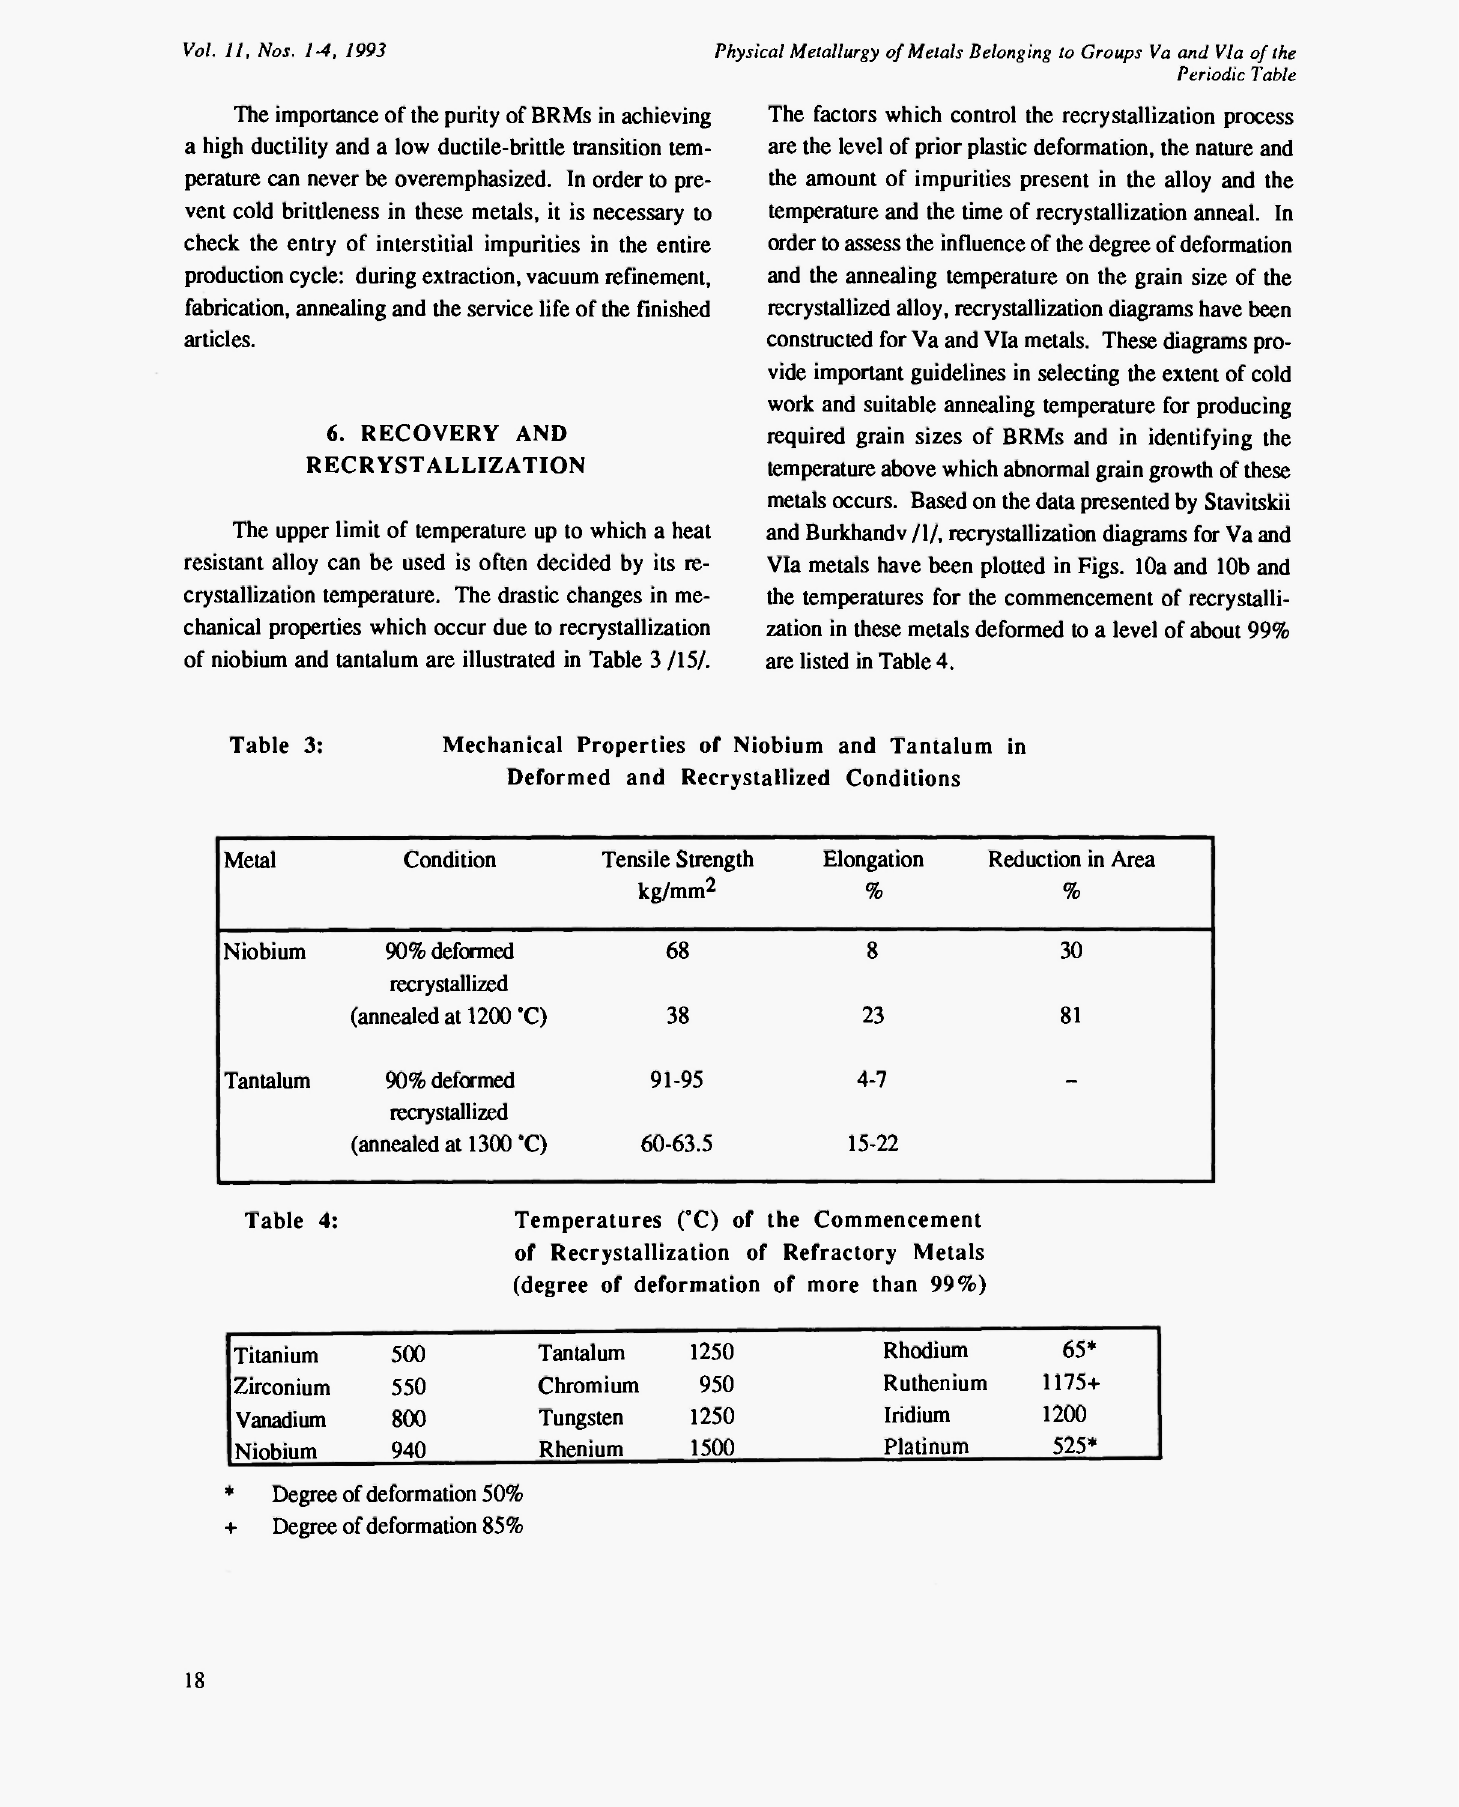
Temperatures (°C) of the